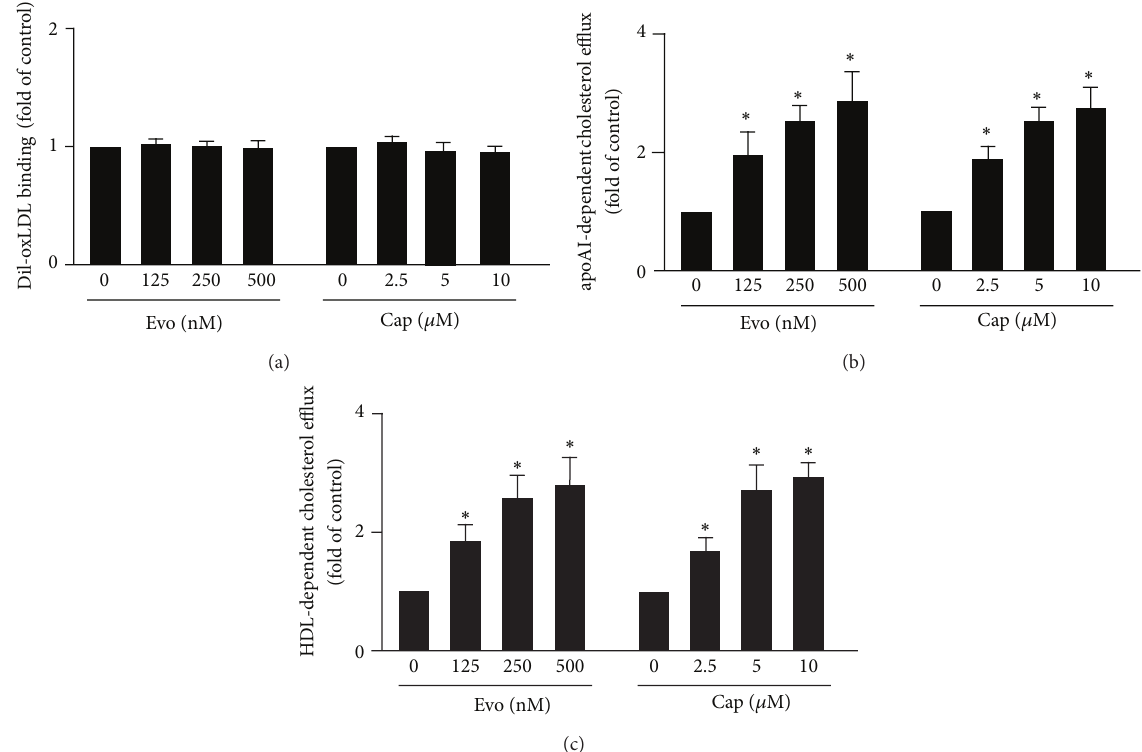
Figure 4: TRPV1 activation by agonists promotes apoAI- and HDL-dependent cholesterol efflux in macrophages. (a) For Dil-oxLDL binding assay, BMDMs were treated with vehicle, evodiamine (125, 250, 500, 500 nM), or capsaicin (2.5, 5, 10 𝜇 M) for 12h and then incubated with 10 𝜇 g/mL Dil-oxLDL at 4 ∘ C for 4h. Cellular lysates were analyzed by fluorimetry. ((b) and (c)) BMDMs were treated with indicated concentrations of evodiamine (125, 250, 500, 500 nM) or capsaicin (2.5, 5, 10 𝜇 M) for 12h, followed by NBD-cholesterol (1 𝜇 g/mL) for another 6h in the presence of (b) apoAI (10 𝜇 g/mL) or (c) HDL (50 𝜇 g/mL). The medium and cell lysates were collected for the measurement of fluorescence. Cholesterol efflux was defined as fluorescence in the medium relative to total amount of fluorescence. Data are mean ± SEM from 5 independent experiments. ∗ 𝑃 < 0.05 versus vehicle